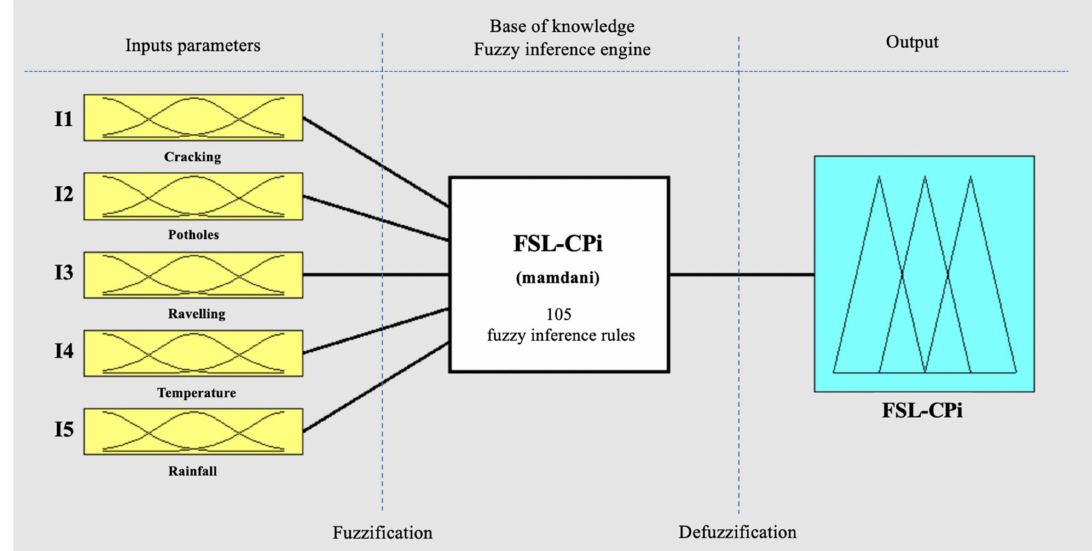
Figure 6. The hierarchical structure of the FSL-CPi fuzzy logic